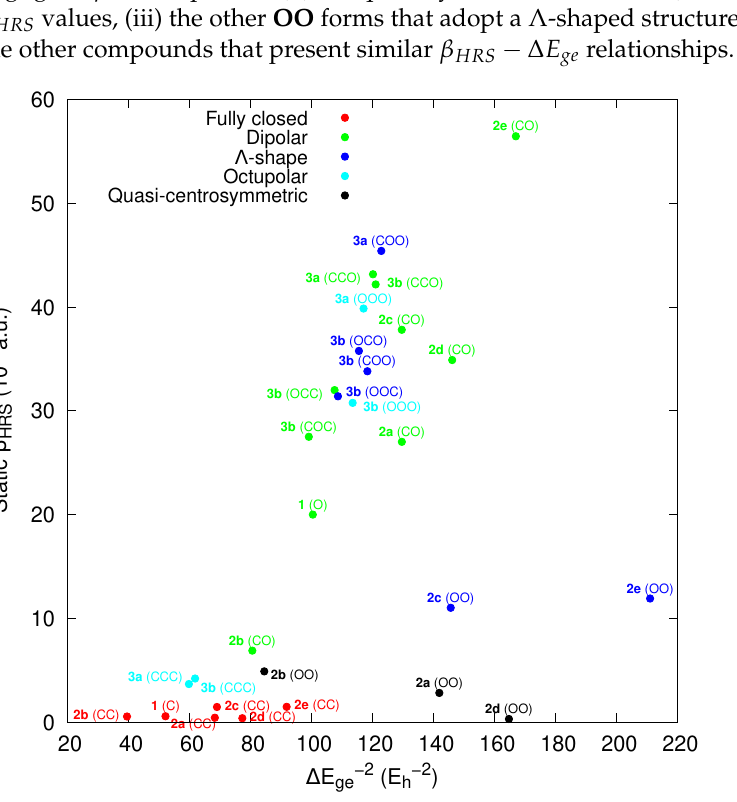
Figure 8. Correlation between the static β HRS and ∆ E − 2 ge for the different types of NLOphores. All values were calculated at the TDDFT/M06-2X/6-311+G(d)/IEF-PCM (acetonitrile) level of